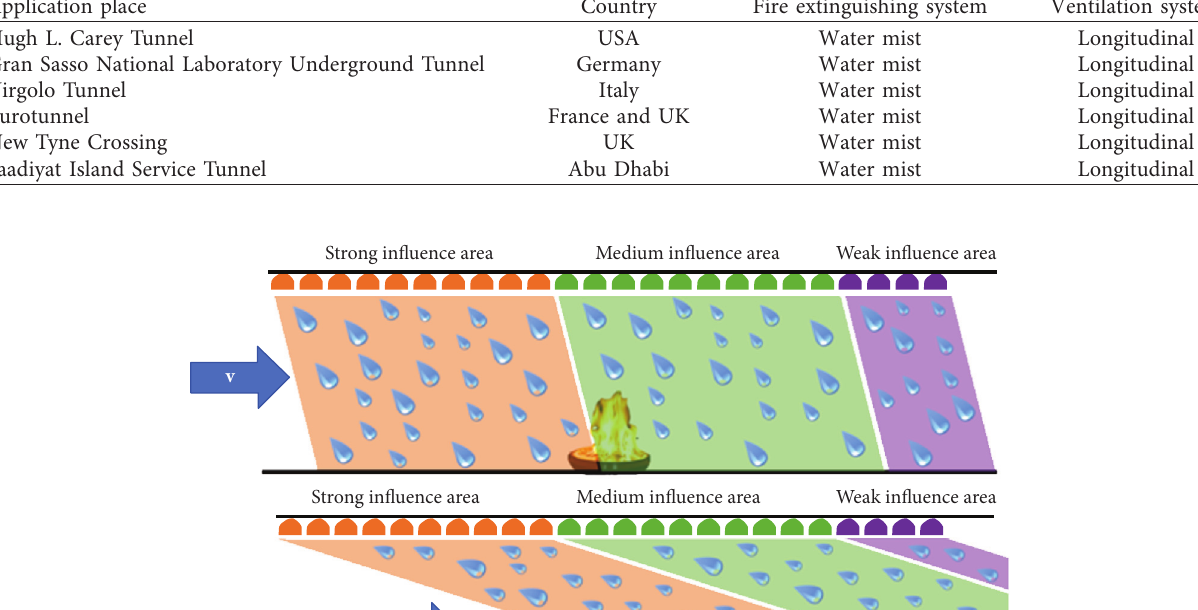
Table 1: Typical engineering application of the water mist fire extinguishing system in the tunnel space. Application place